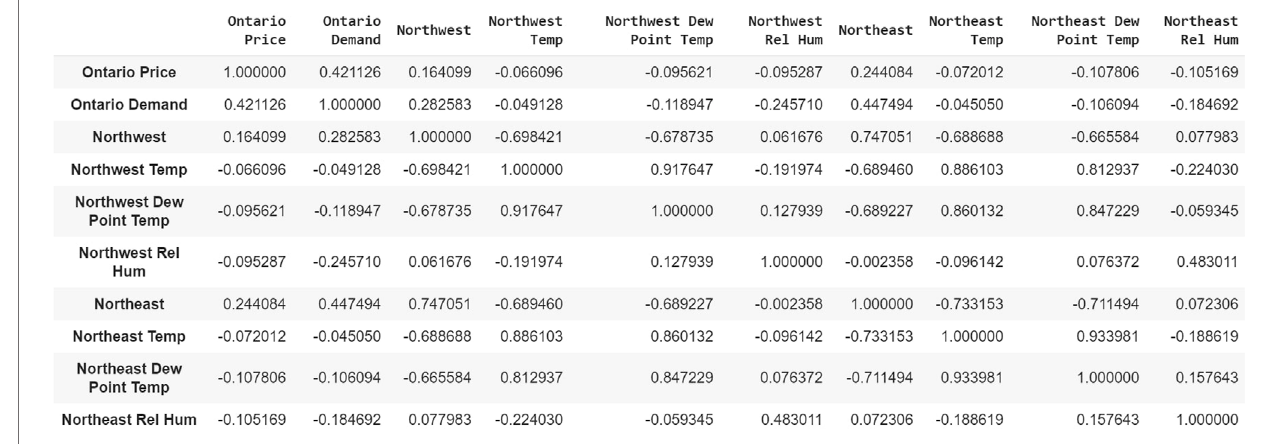
FIGURE 5 | Correlation matrix (Ontario Demand Data).